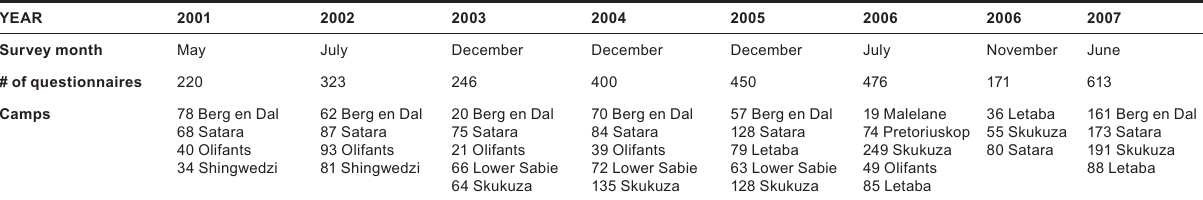
Table 2 Total number of questionnaires completed – 2001 to 2007